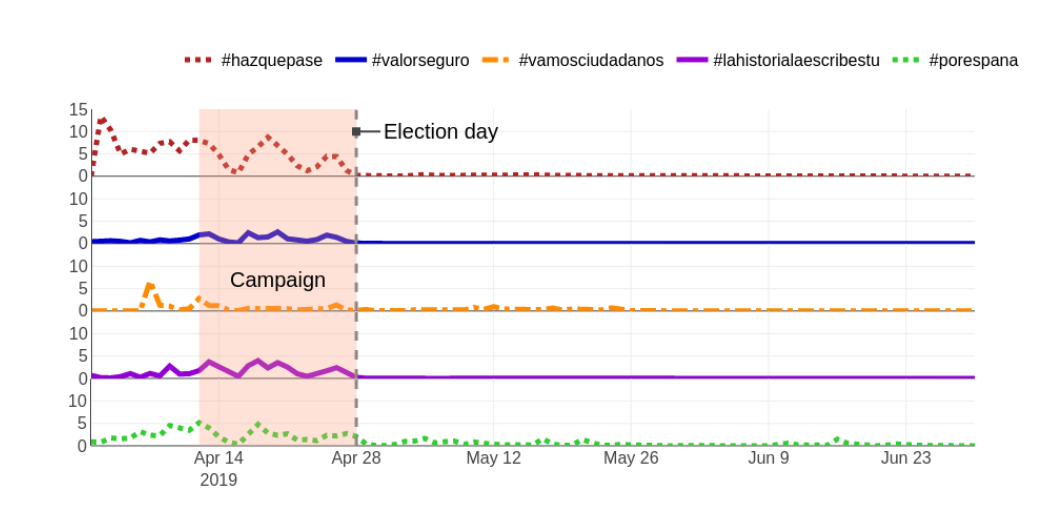
Figure 6. Daily relative amount of tweets extracted using each party’s slogan (#hazquepase, #valorseguro, #vamosciudadanos, #lahistorialaescribestú, and #porespaña) in percentage. Notice how the activity ceases after the election